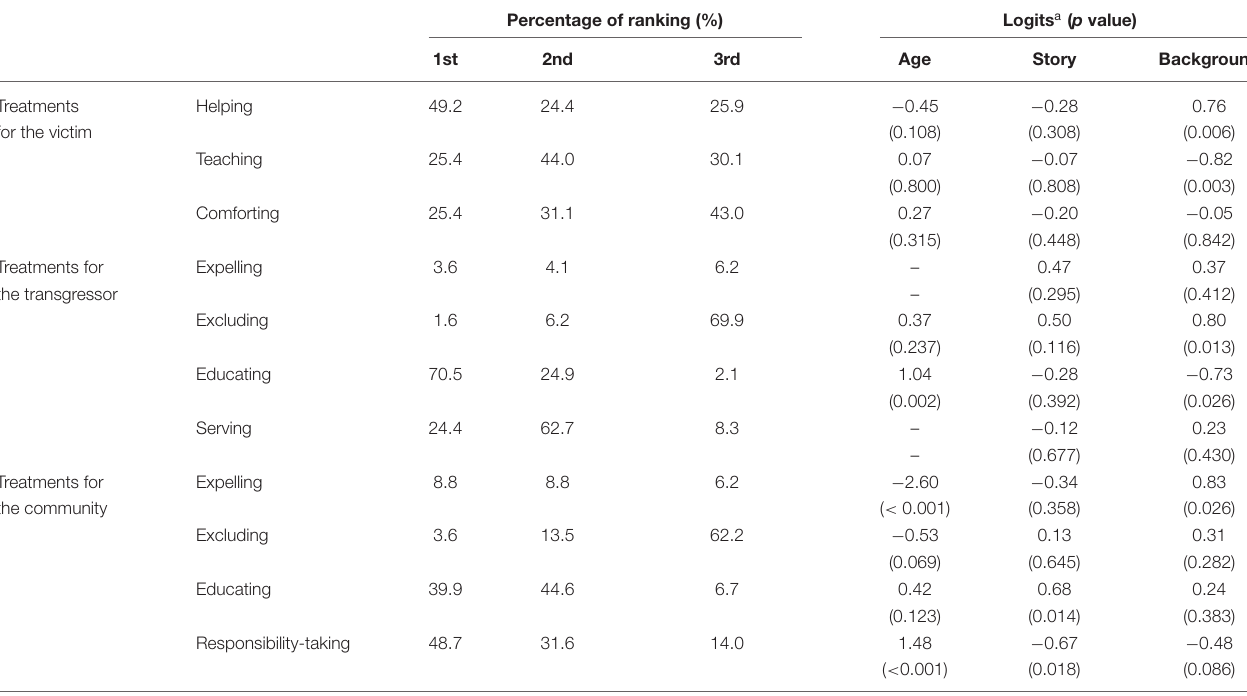
TABLE 5 | Percentage of ranking for community-level solutions and the results of ordinal regressions predicting rankings from age, story type, and hardship